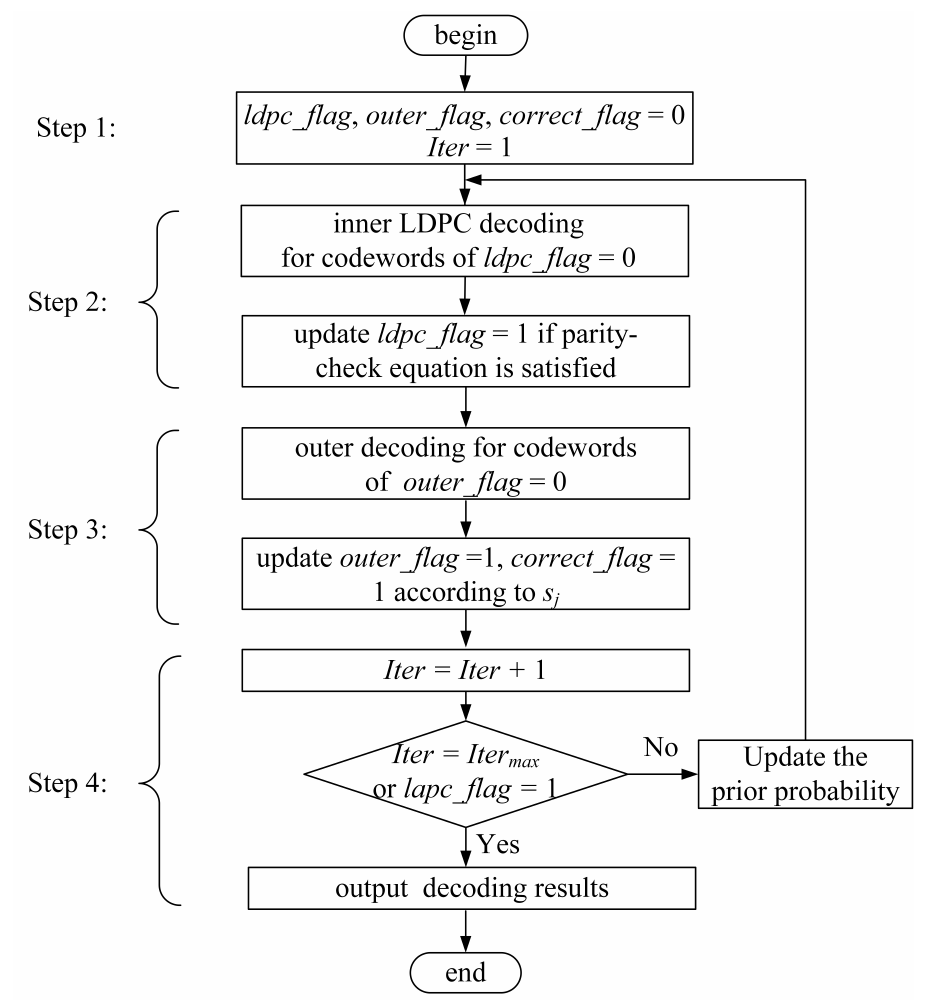
Figure 5. The overall flow diagram of the iterative decoding process of the product